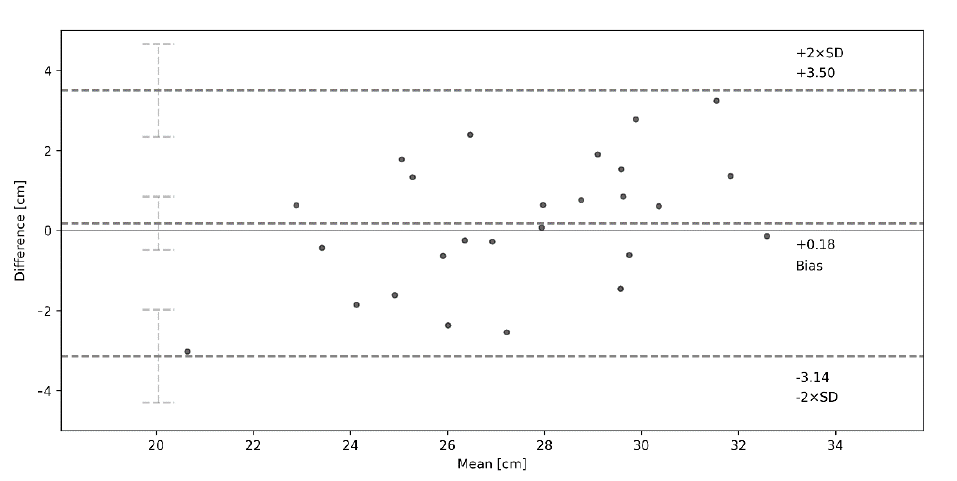
Figure 4. Force plate vs. IMU measuring SQJ height agreement (Bland-Altman plot).